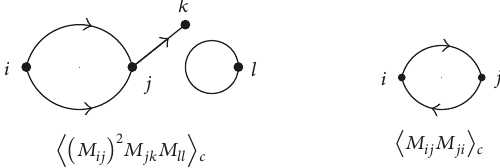
Figure 2: Examples of graph associated with